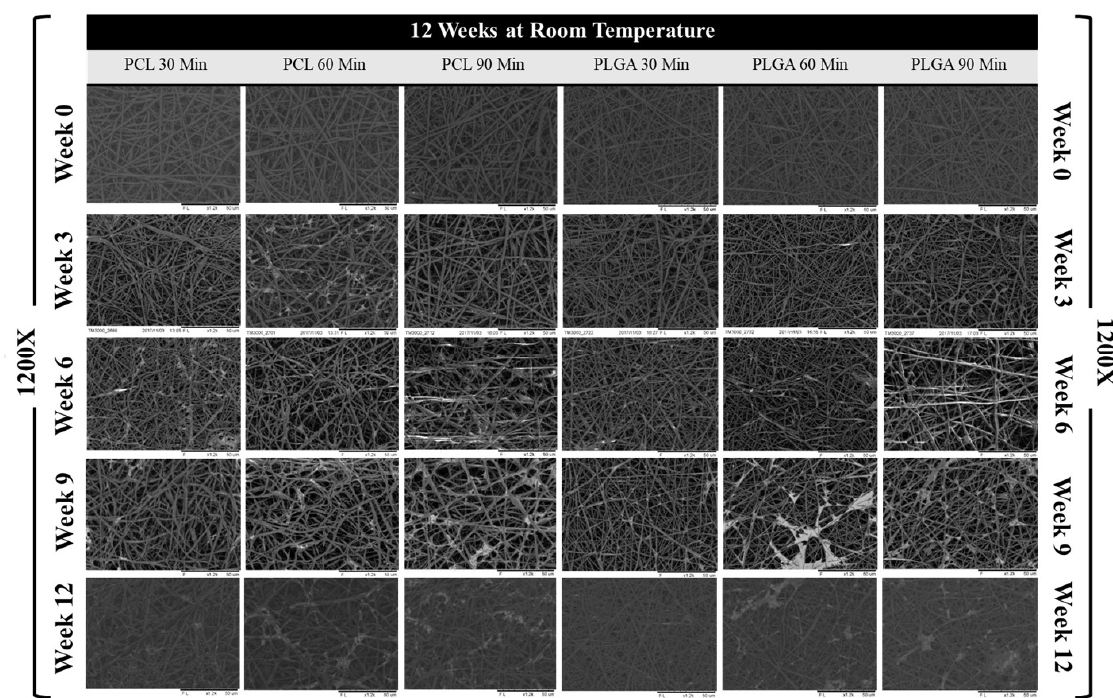
Figure 4. SEM images of electrospun PCL and PLGA scaffolds from weeks 0, 3, 6, 9 and 12 (the degradation period) at 1200× magnification; scale bar: 50 µm.